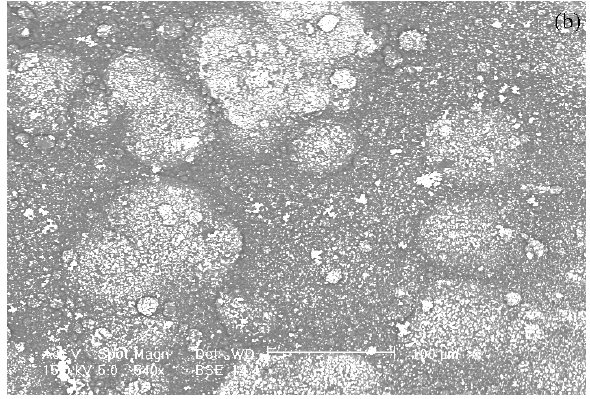
Figure 4b. Analysis of the RVC-PPy 0 electrode after Cd electrodeposi- tion by scanning electron microscopy (SEM) using a backscattered elec- tron image